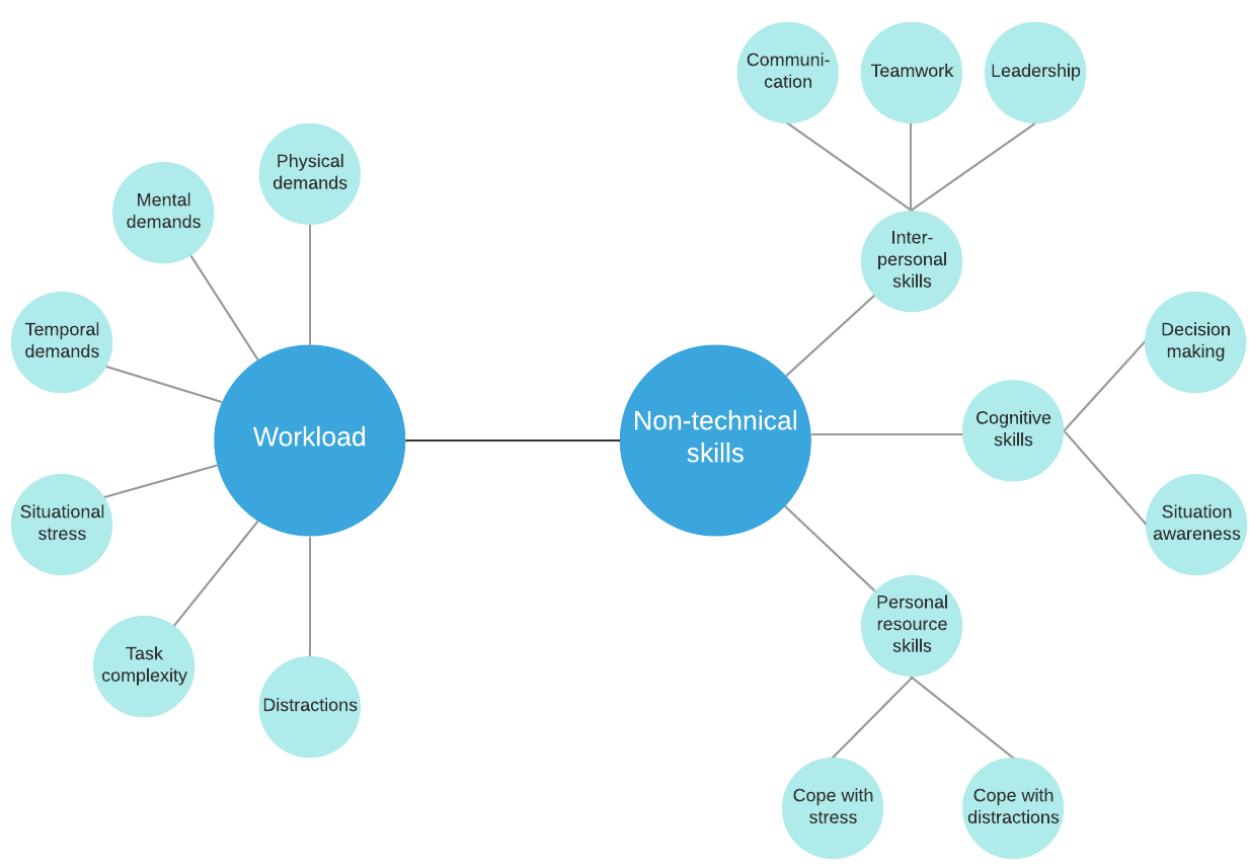
Figure 2. Workload categories and non-technical skills in Robot-Assisted Minimally Invasive Surgery (RAMIS), based on the SURG-TLX workload questionnaire and the ICARS expert-rating assessment tool. At the moment, there is no universal solution for mental workload assessment specifically created for